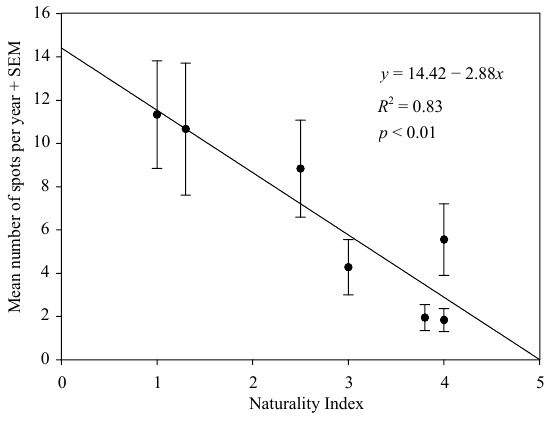
Figure 5. Correlation between the Naturality Index of different spruce forest types and the mean number of infestation spots suffered